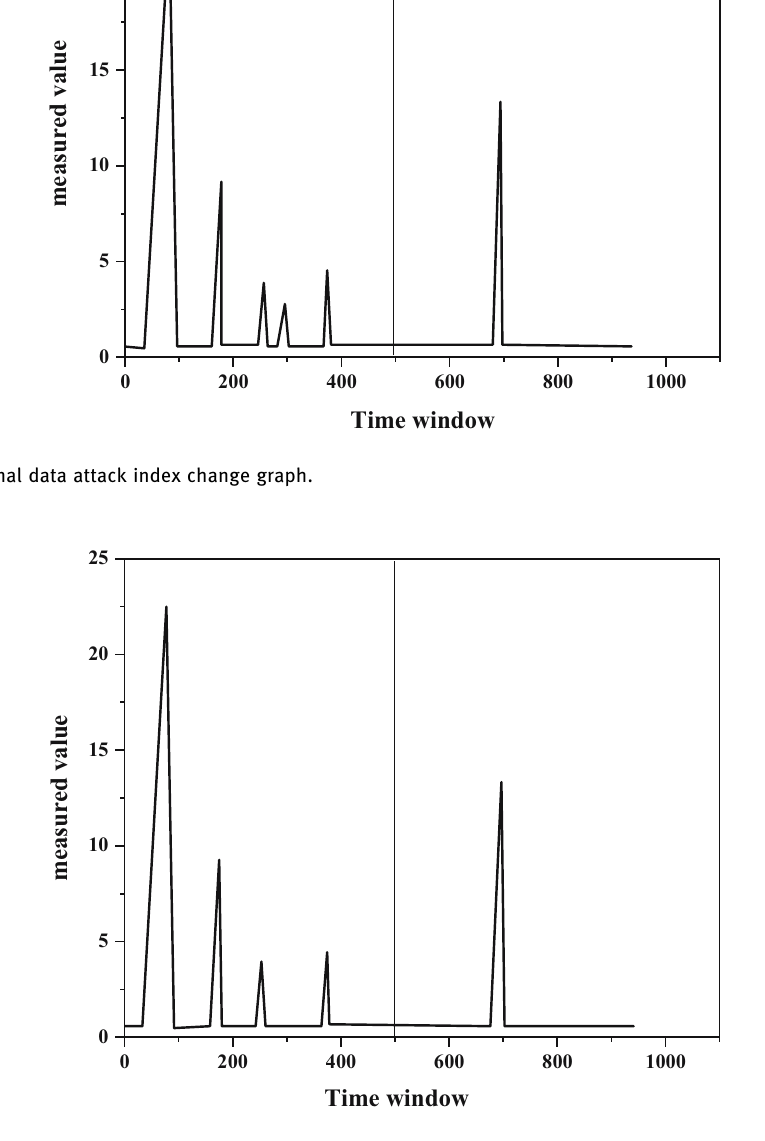
Figure 5: Changes in attack index after reducing